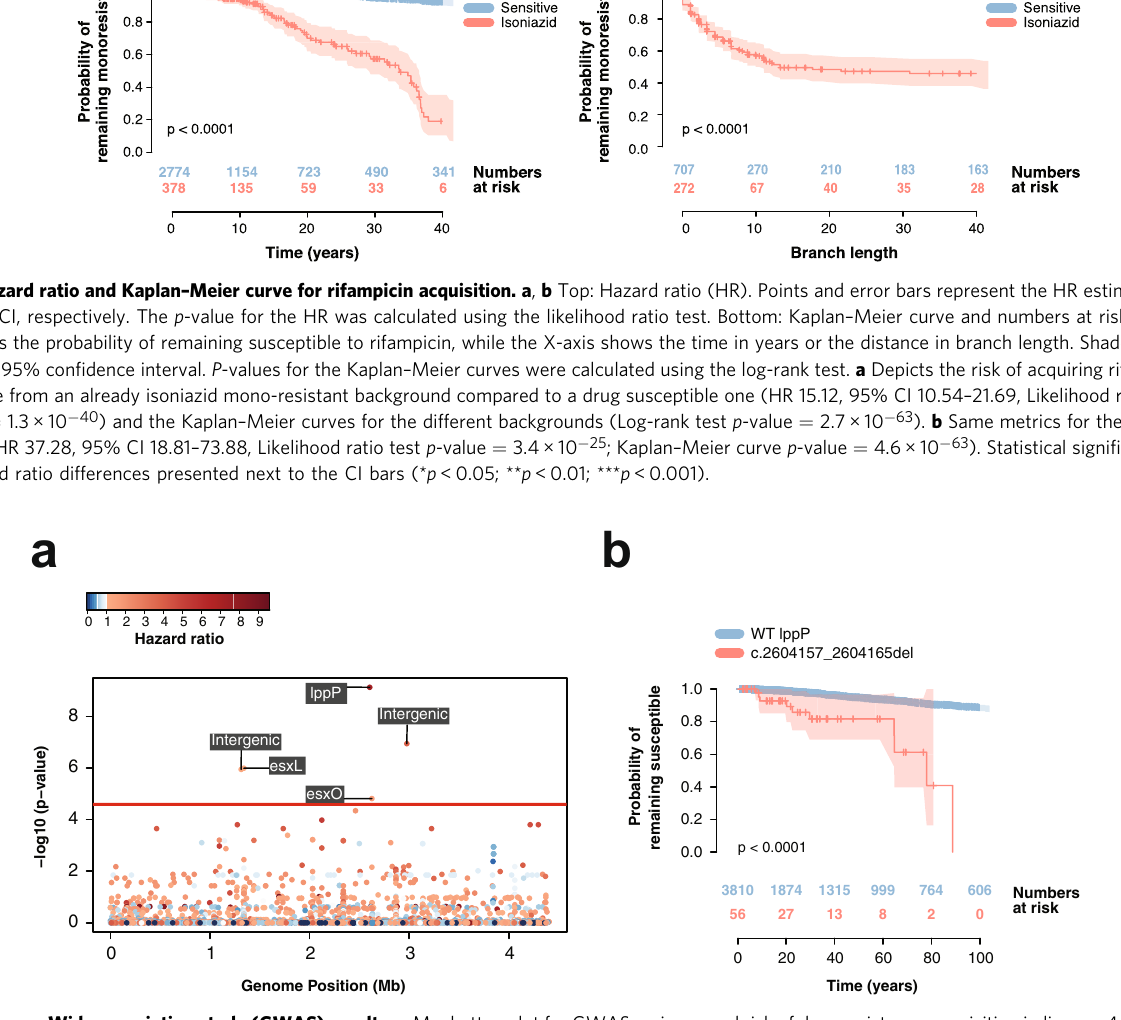
1,341,044 with a hazard ratio of 3.2 (HR 3.2 95% CI 1.91 – 5.37, p - value = 1.01 × 10 − 6 ), and at position 2,626,011 in the gene esxO (HR 11.12, 95% CI 5.50 – 22.5 p -value = 1.52 × 10 − 5 ) with a frequency in the population of 17 and 5%, respectively. In the L4 global dataset, the esxL SNP had a frequency of 19.5% while the esxO polymorphism was present in 10% of the isolates. Inferred